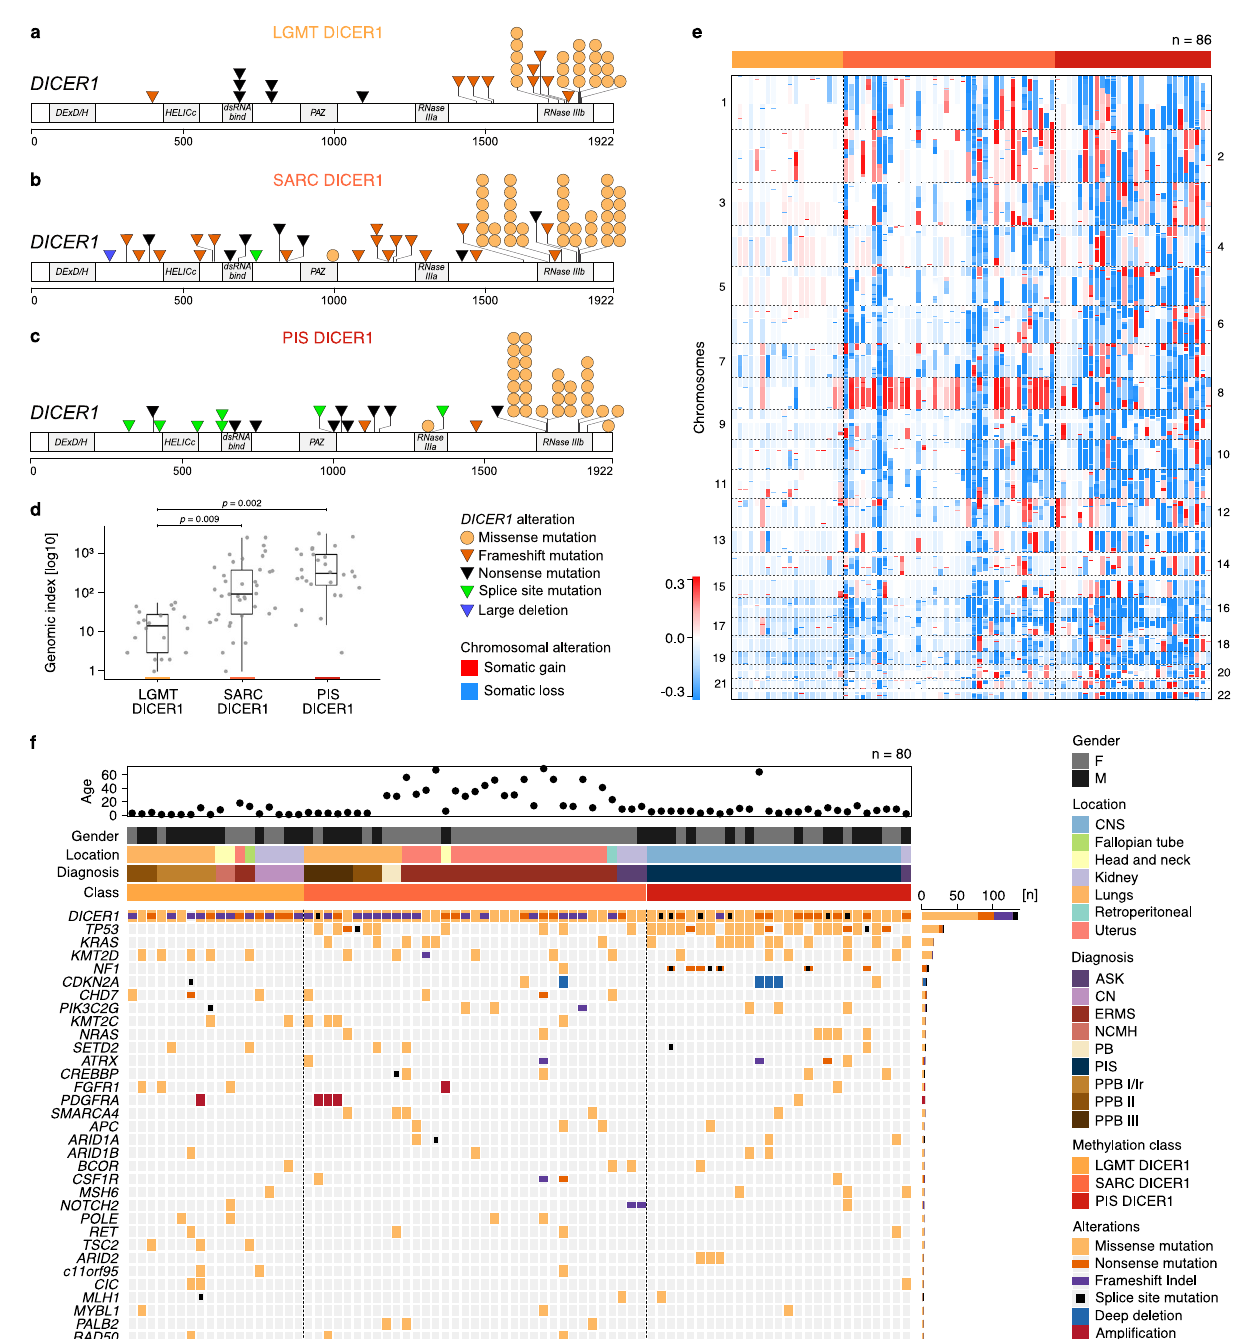
Fig. 3 | Molecular characteristics of mesenchymal neoplasms with DICER1 alteration. DICER1 variants identi fi ed in a LGMT DICER1, b SARC DICER1 and c PIS DICER1. d Genomic index (total number of segmental gains or losses 2 /number of involved chromosomes) of LGMT DICER1, SARC DICER1 and PIS DICER1, indicative of genomic complexity ( n =86). Black lines mark the median, edges of boxes denote interquartile range (IQR), and vertical lines indicate 1.5 × IQR. Statistical signi fi cance was determined by the Games-Howell post-hoc test. e Case-by-case